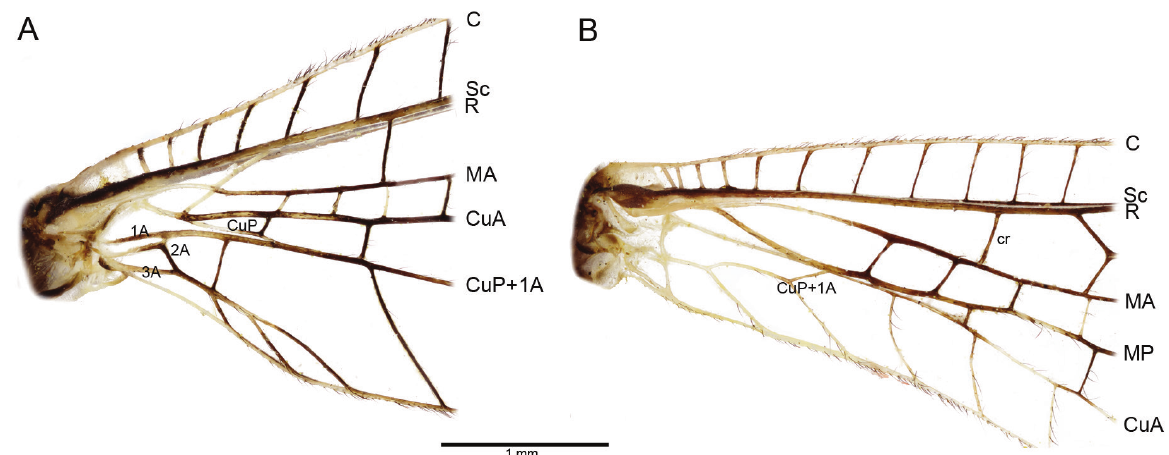
Figure 5. Base of fore- and hindwing of Megistopus , showing diagnostic wing characters of Nemoleontini. A forewing of Megis - topus flavicornis [Italy, Liguria]; B hindwing of same specimen. Abbreviations: C – Costa, Sc – Subcosta, R – Radius, Rs – Radius sector, MA – Media anterior, MP – Media posterior, CuA – Cubitus anterior, CuP – Cubitus posterior, A – Anal vein, cr – presec- toral crossvein.